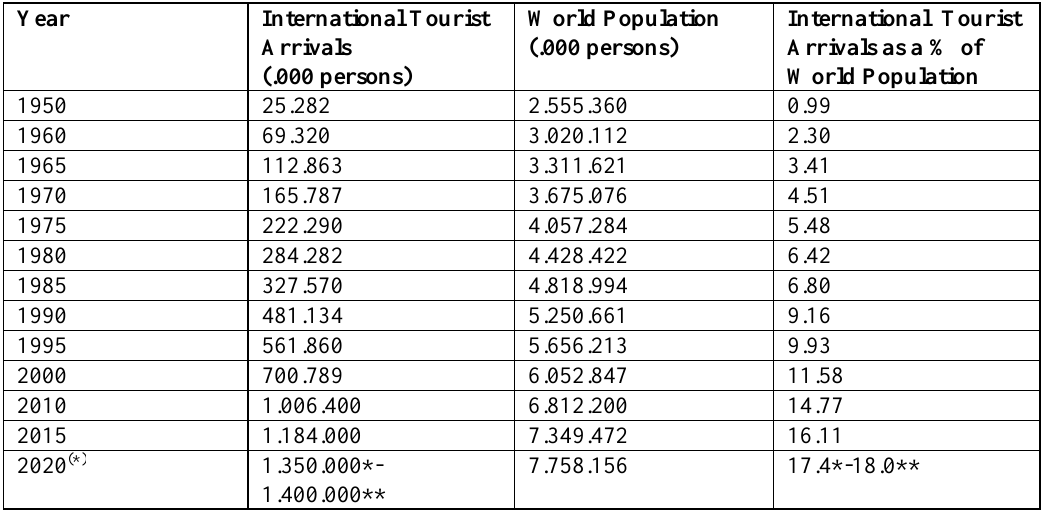
Table 1: International Tourist Arrivals and World Population